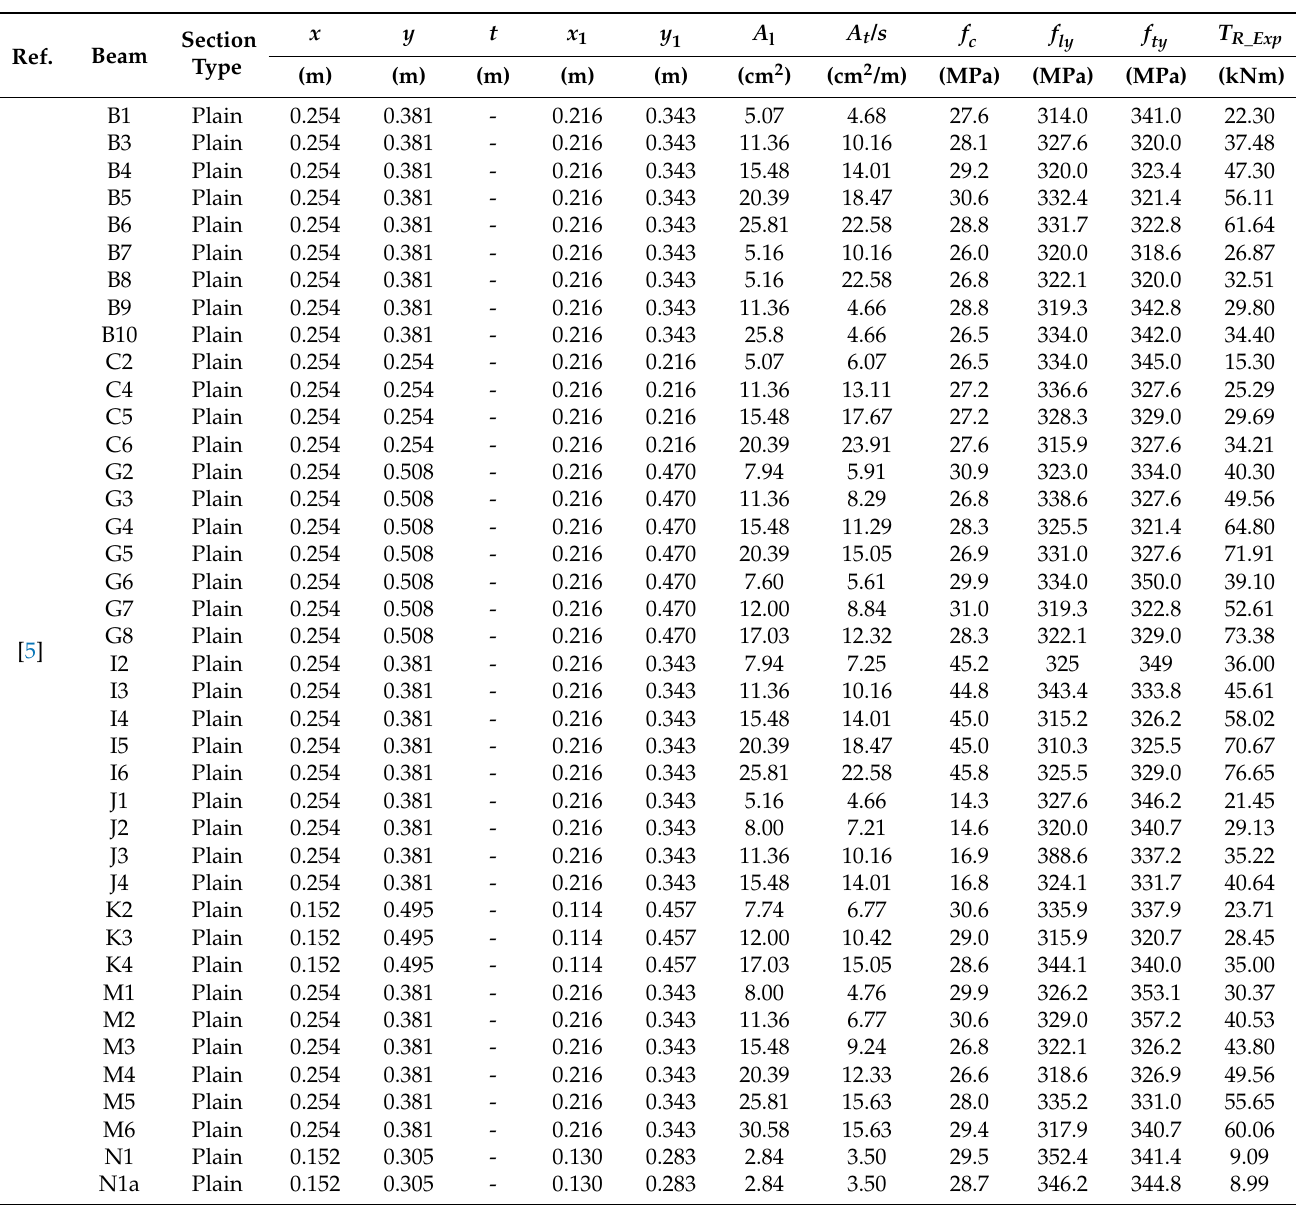
Table A1. Geometric and mechanical properties of the reference RC